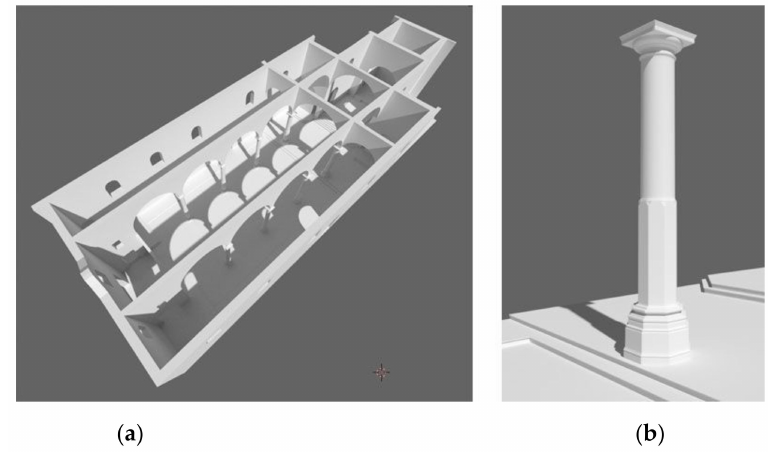
Figure 5. Detailed three dimensional (3D) models: ( a ) building and architectural structures, ( b ) pillar. Source: Cor-Ignis